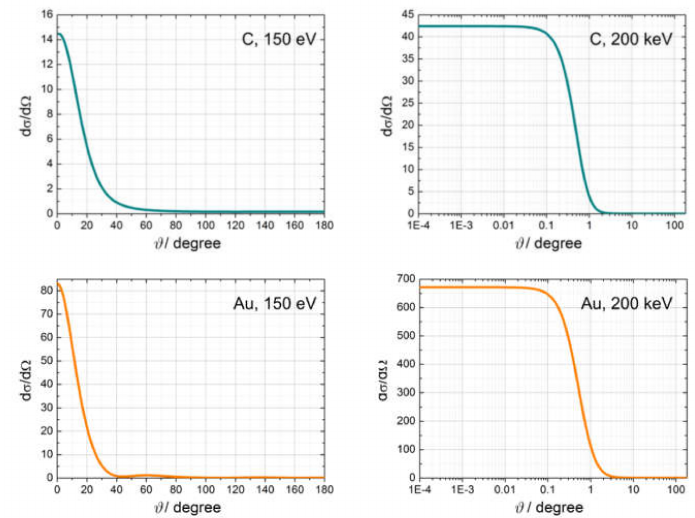
Figure 2. Di ff erential scattering cross-sections d σ /d Ω of 150 eV and 200 keV electrons scattered by C and Au atoms, calculated as a function of the scattering angle ϑ . The units for the di ff erential cross-sections are a 2 /sr, where a 0 is the Bohr radius. 0